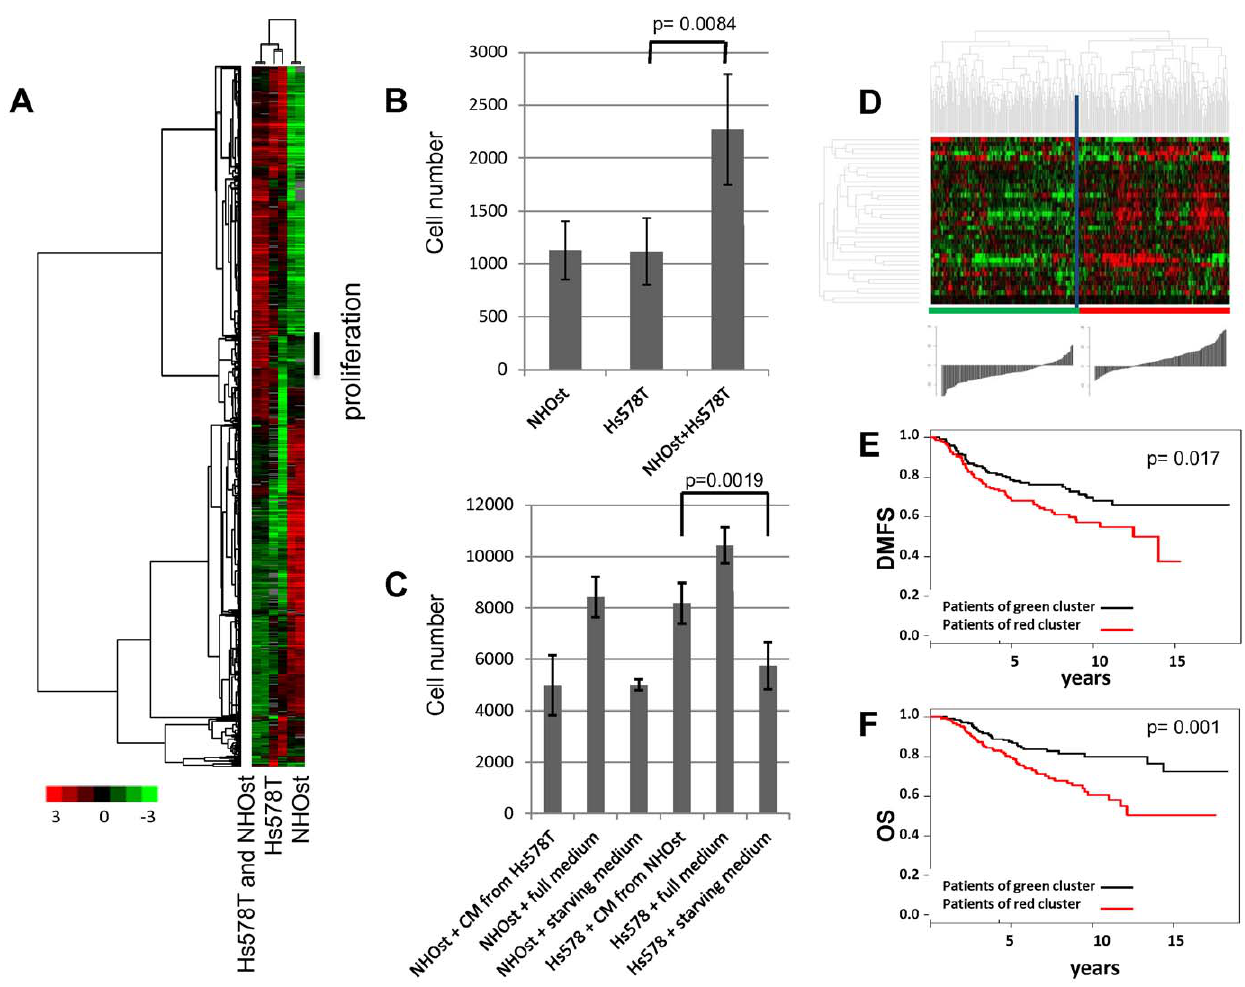
Figure 1. Effects of a heterotypic interaction between normal human osteoblasts and breast cancer cells. ( A ) Biologically independent replicates of NHOst, Hs578T, and the mixed co-culture of NHOst and Hs578T were kept for 48 hours at low serum conditions and characterized by DNA microarray profiling. We performed hierarchical clustering of 1923 elements that display a greater than 3-fold variance in expression in more than 2 different experimental samples. Genes are represented in rows and experiments in columns. Unsupervised hierarchical clustering of the experiments grouped the biological replicates together. The vertical black bar marks a cluster of genes that were higher expressed in all co-cultures compared to both monocultures, which indicated that they were induced by the heterotypic interaction. Further analysis of these genes revealed that they were specific for proliferation and mitosis. ( B ) The proliferation rate of NHOst and Hs578T cell monocultures and of their 1:1 co-culture was determined by measuring increases in cell number by direct cell counting. Quadruplicates of pre-starved cells were plated at a density of 8500 cells/ cm 2 and after 48 hours the cell number was determined using a cell counter All figures represent averages from four replicates, and error bars denote standard deviation. The increase in cell number of the co-culture is significantly higher than the increase in both of the monocultures (p=0.0084, un- paired, two-tailed t -test). ( C ) Hs578T cells and NHOst cells were incubated for 24 hours with conditioned media (CM) from NHOst cells or Hs578T cells, respectively, and compared to a negative control of the same cells incubated with autologous medium. All experiments were performed in triplicates. After 24 hours cell numbers were measured by the cell counting with FACS. ( D ) The expression values of the genes in the ‘‘tumor-osteoblast cell- induced M phase/cell cycle’’ gene signature were extracted from a published expression study of 295 early stage breast cancers from the Netherlands Cancer Institute. Genes and samples were organized by hierarchical clustering. The tumors were segregated into two groups that were defined by high or low expression levels of the 36 genes matching the proliferation gene cluster. The histogram below the heat map represents the differences in the sums of log2 ratios among groups. Based on the distributions, the sums of the log2 ratios for the ‘‘proliferation’’ transcripts were over- expressed in the majority of the cases in the right branch of the cluster compared to the left branch of the cluster (32/113 versus 105/45 scores below/above reference zero value, respectively). ( E + F ) Correlation of the ‘‘proliferation’’ gene signature with distant metastasis-free survival (DMFS) (E) and overall survival (OS) (F). Kaplan-Meier curves for the clinical outcomes of the indicated tumors that exhibited high (red curve) and low (black curve) expression of the ‘‘proliferation’’ signature are shown. doi:10.1371/journal.pone.0029743.g001 NOP58, and HMGB2 ( Figure S1 ). The frequency of the genes directly annotated as involved in DNA replication. The up- regulation of these gene sets suggests proliferation of the co-culture that are involved in this function was significantly enriched of the breast cancer cells (Hs578T) and osteoblast cells. (p = 0.049) compared to the background of 922 genes passing the data quality and data distribution filters, as shown in the heat map As implied by the higher expression of the ‘‘proliferation’’ gene of Figure 1 and present in GO::TermFinder database. Out of these signature, the proliferation rate, as determined by direct cell 17 genes, 5 (MCM3, ORC6L, CHEK1, CDC7, and PCNA) are counting over time, was significantly higher in the co-culture of